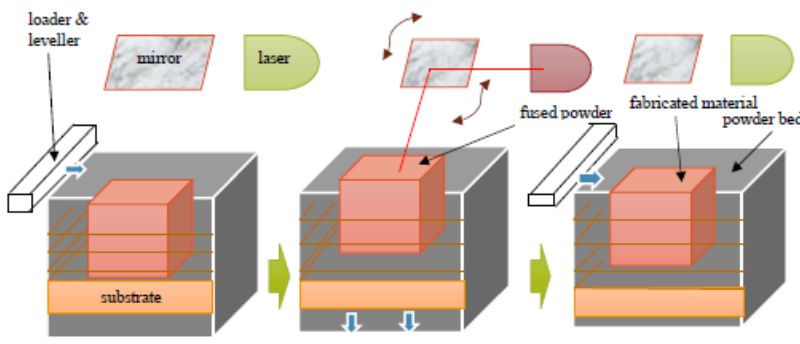
Figure 4. Schematics of Selective Laser Melting process—flow diagram.